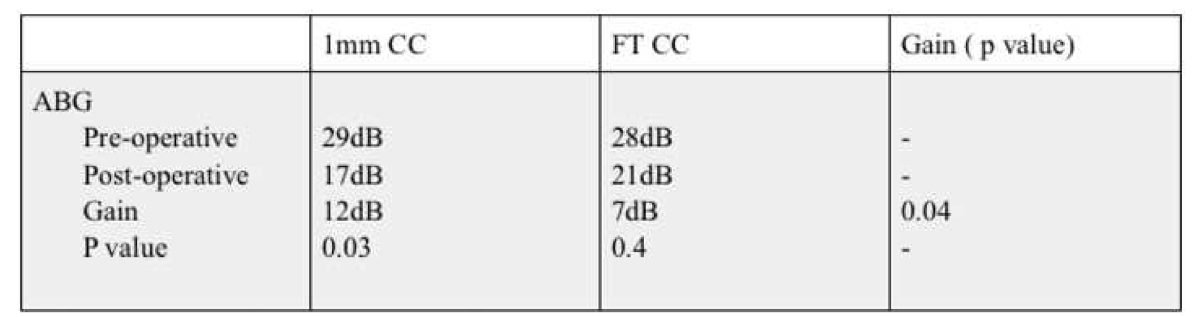
Table 1 Preoperative and postoperative pure tone